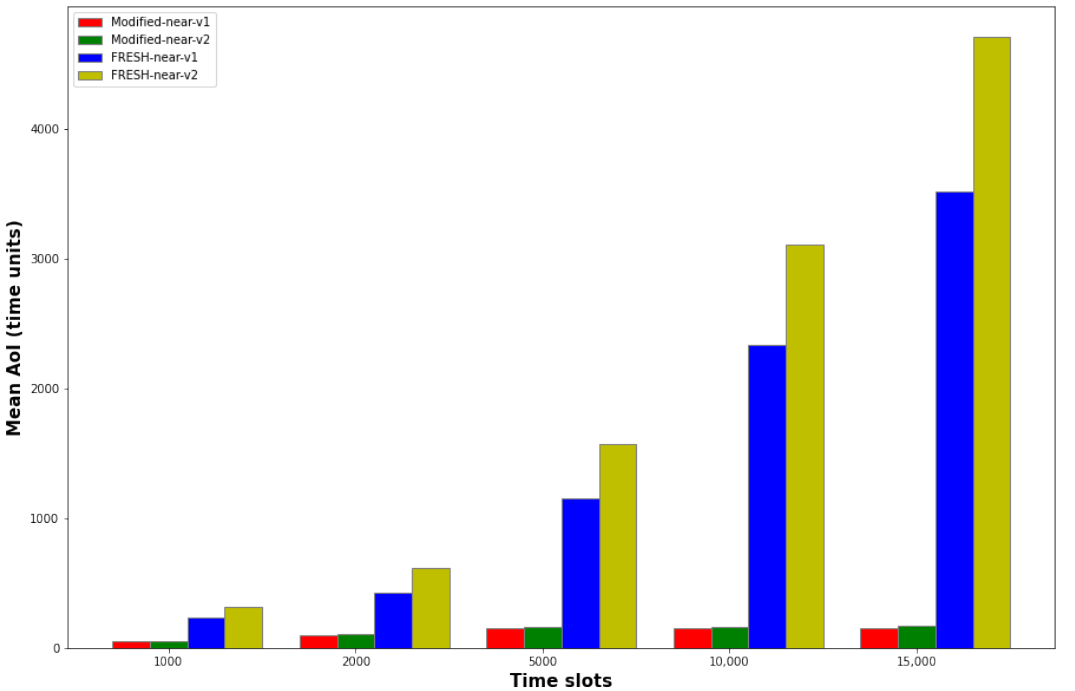
Figure 6. Dependence of AoI versus number of time slots for Modified-near-v1, Modified-near-v2, FRESH-near-v1 and FRESH-near-v2